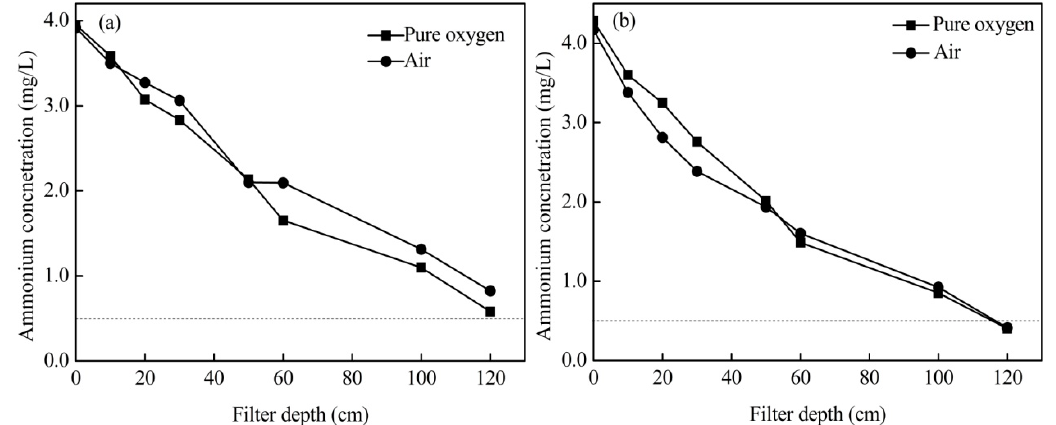
Figure 6. Ammonium removal efficiency with aeration at different positions: ( a ) aeration from the bottom and ( b ) aeration from 1/3 of the height of the filter bed (40 mL/min pure oxygen and 100 mL/min compressed air).